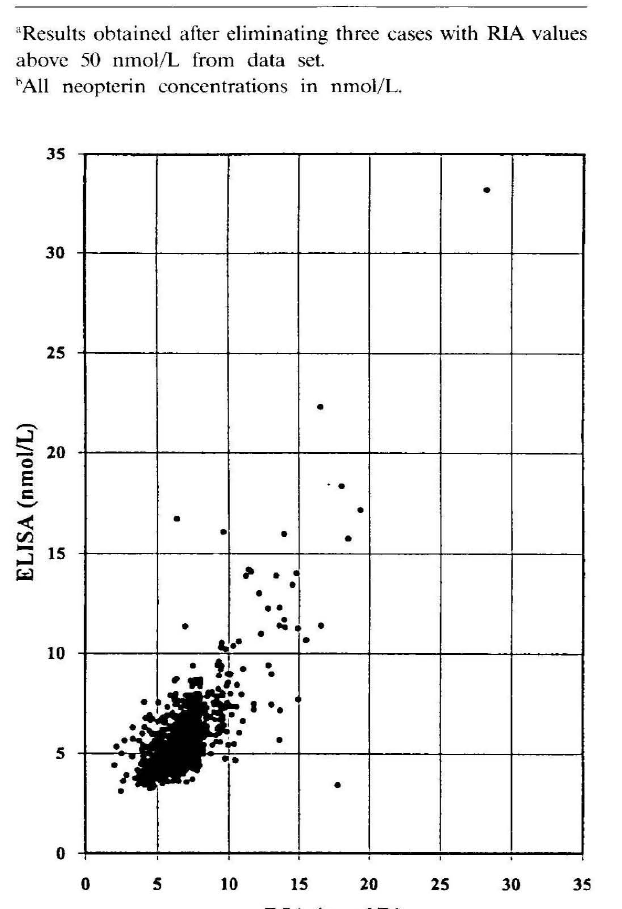
Figure 1. Comparison of initial results obtained by RIA and ELISA technique on )040 blood donors. Three outliers by RIA are not shown: their measured concentrations in nmol/L were 60.7/5.9 (RIN ELISA). 80.0/5.2 and 319.7/5.9.